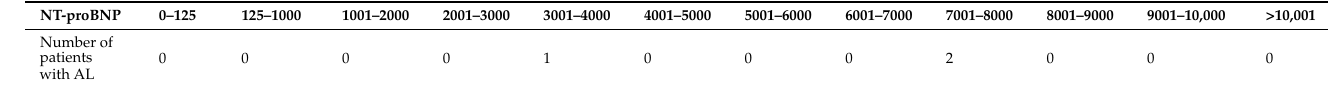
Table 11. NT-proBNP dosage for AL positive patients.